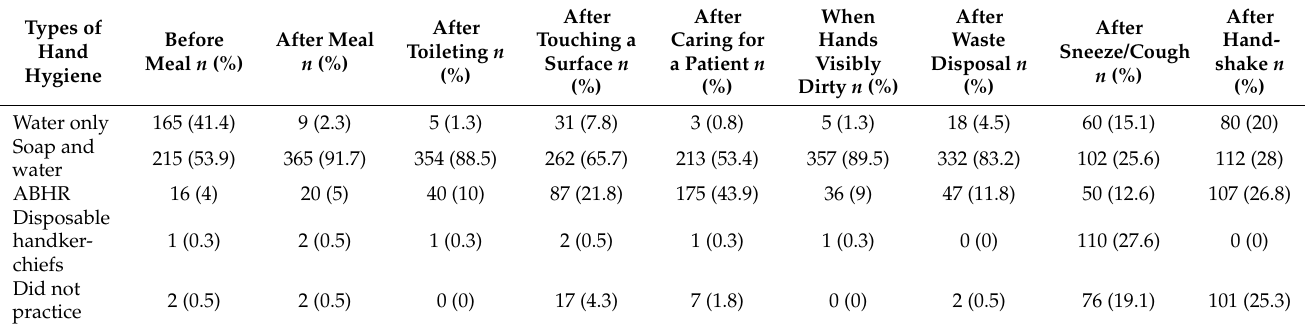
Table 5. Participants’ hand hygiene practices and methods used in the nine key actions ( n =